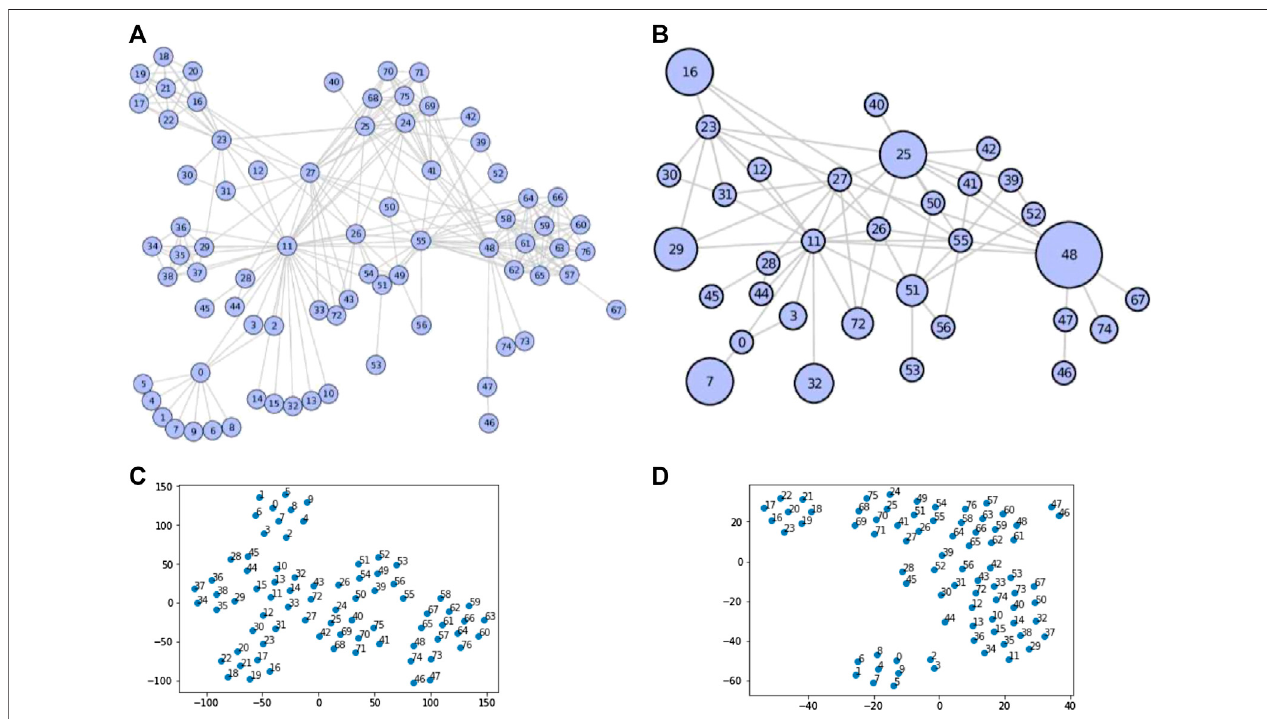
FIGURE 1 | Example of graph compressing on Les Miserables network (Original Network (A) , Compressed Network (B) , Embedding of Original Network (C) and Embedding of Compressed Network (D) ).